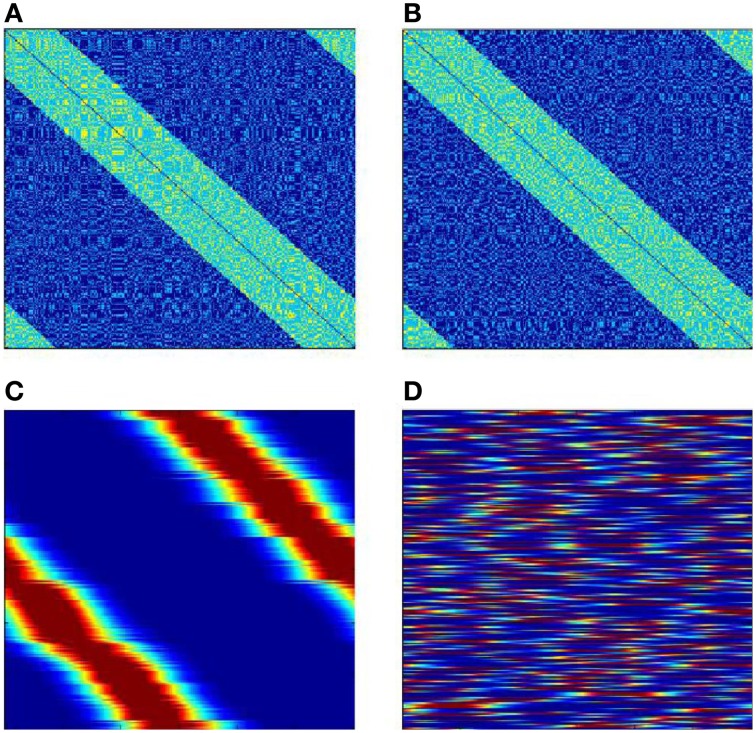
SOM with two possible attractors for mapping input signals. (A,B) are two views of neural network interconnection matrix T in the first in the second enumerations (the dimensions of the figures are N × N; the connection weight is color-coded: dark blue, −10; light blue, 1; yellow 2. (C,D) the connection matrix W after completion of learning, (C) neurons are numerated in the first enumeration; (D) neurons are numerated in the second enumeration. The number of neurons N = 300, the number of receptors R = 300. The Figure demonstrates that of two existing circular bump attractors, which exist in the neural network, the SOM process “selects” only one to use for mapping of the input signals.